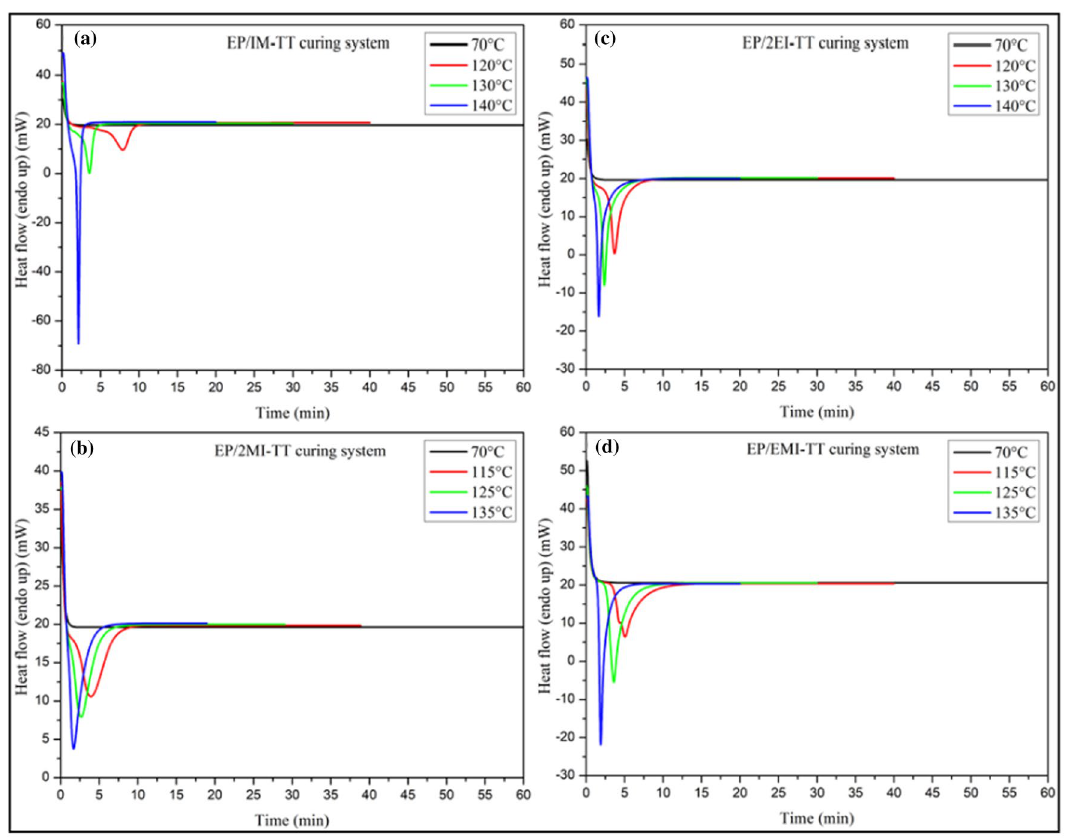
Fig. 8 Isothermal DSC curves of the EP blends